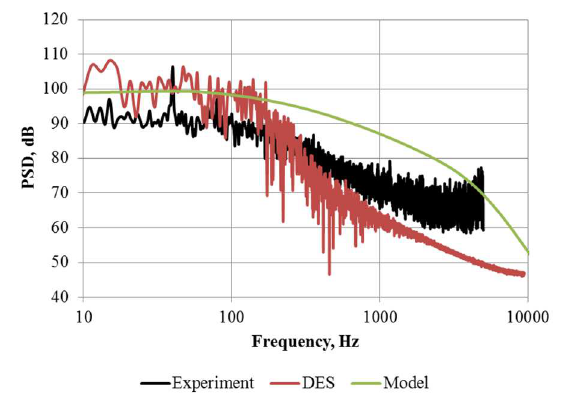
Fig. 16. Comparison of PSD at point № 11 based on the different